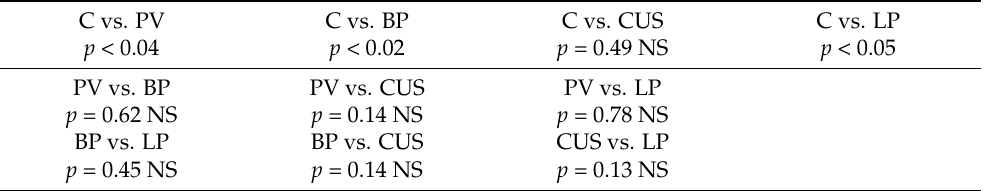
Table 3. Expression of STAT6 in study groups. C—control group; BP—pemphigoid; PV—pemphigus vulgaris; LP—lichen planus; CUS—chronic ulcerative